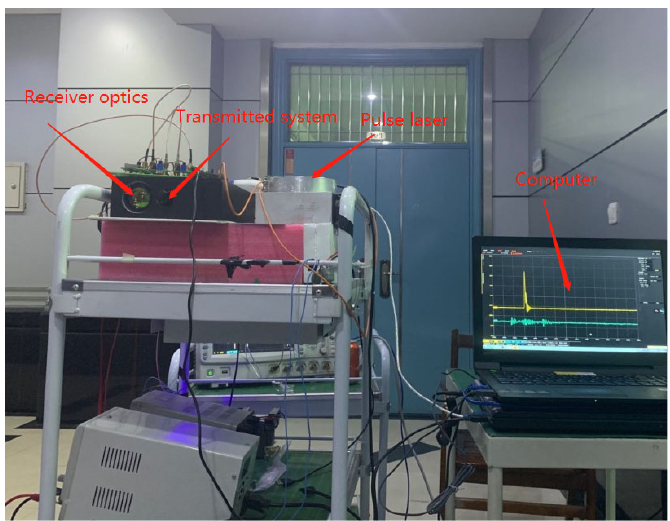
Figure 5. Experimental equipment diagram of the pulse Lidar ranging system. Table 2. Specifications of the Lidar